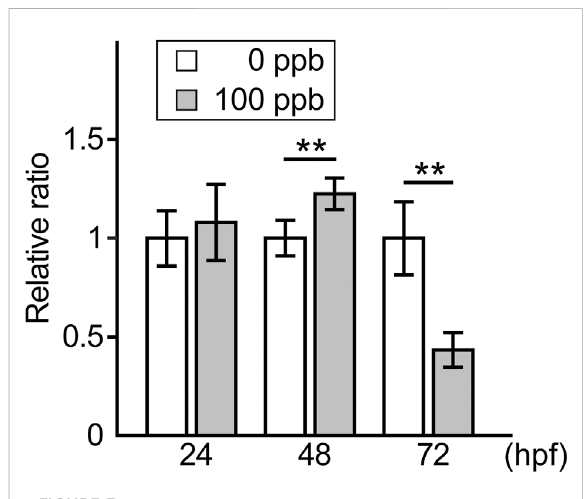
ROS level in the Pb-exposed (100 ppb Pb) and the control (0 ppb Pb) zebra fi sh embryos/larvae. Relative ratio of ROS amount per embryo/larva to the mean of control at 24, 48, and 72 hpf are shown in the bar graph representing the mean ± SD. Statistical signi fi cance was calculated by the Student ’ s t -test compared between control and Pb-exposed groups at each time point. ** p < 0.01. Number of trials = 3, n = 13 – 23. Each trial consisted of three